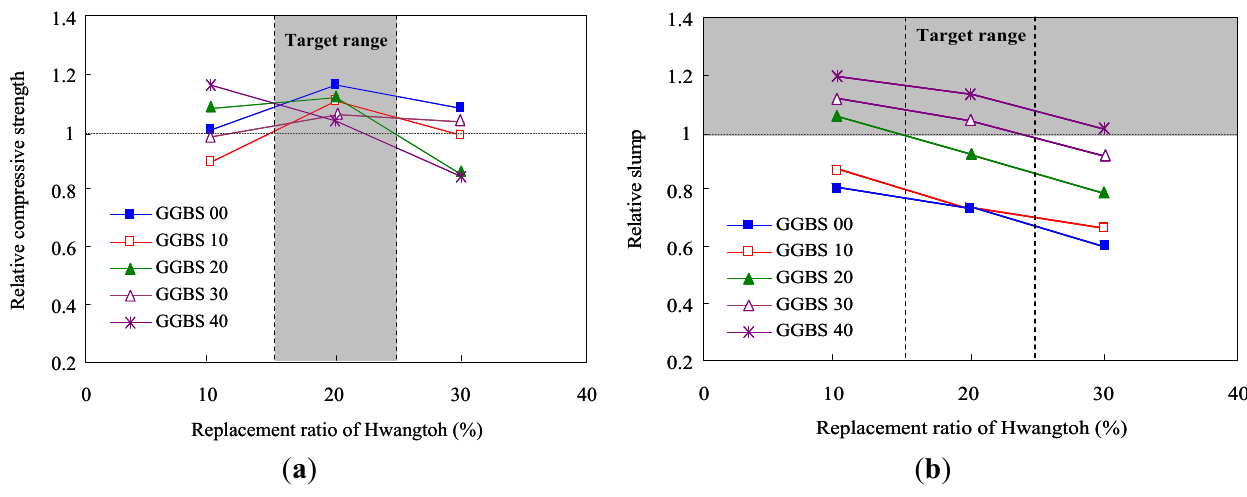
Figure 1. Compressive strength and slump of Hwangtoh concrete according to pre-tests ( a ) Compressive strength and ( b )